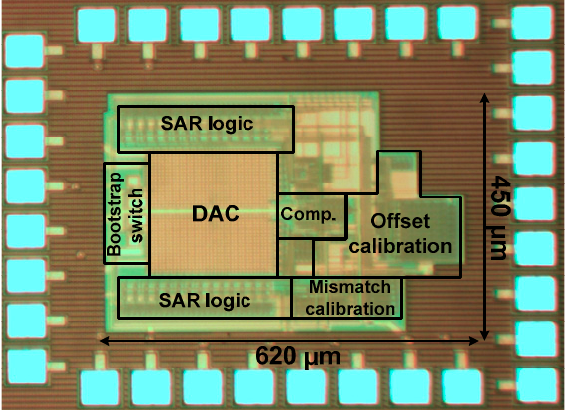
Figure 19. Microphotograph of fabricated ADC.